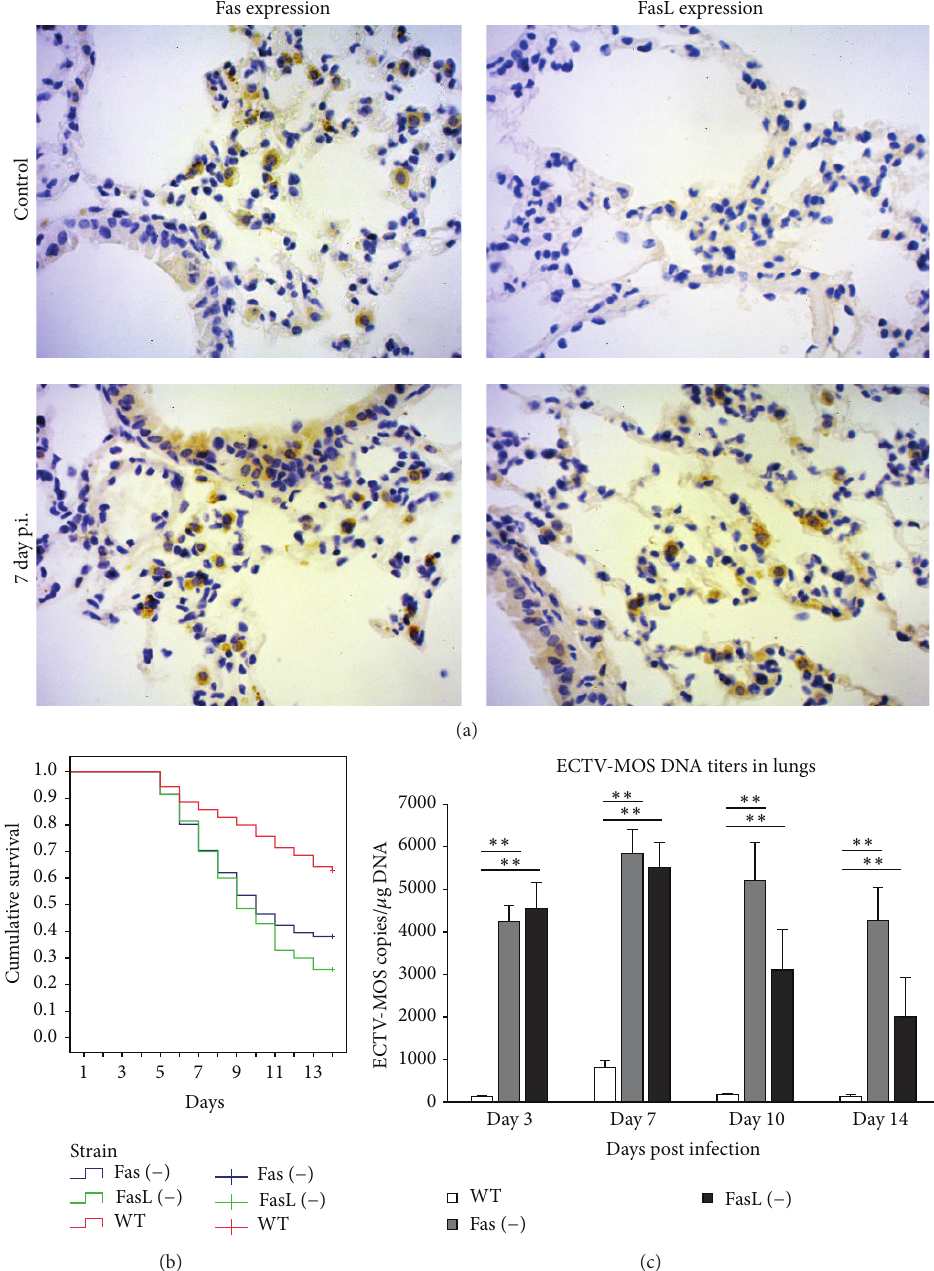
Figure 1: Lack of Fas and FasL expression results in an increased infection burden during mousepox infection. (a) Fas and FasL expression in the lungs of C57BL/6 mice uninfected and ECTV-infected at the 7thd.p.i. Brown color indicates a positive reaction (Fas+ or FasL − ), while blue color corresponds with hematoxylin positive nuclei. (b, c) C57BL/6 (WT), B6. MRL-Faslpr/J (Fas − ), and B6Smn.C3-Faslgld/J (FasL − ) mice ( 𝑛 = 70 in each group) were infected with 1 × 10 3 PFU of ECTV-MOS and monitored for 14 days. Kaplan-Meier survival analysis using the log-rank test (b) and (c) ECTV titers in lungs. Asterisks along the lines indicate statistical differences between the mice strains. The bars represent the mean from 5 separate experiments ± SEM. ∗∗ Significant differences with 𝑃 ≤ 0.001 in comparison to Fas- and FasL-deficient